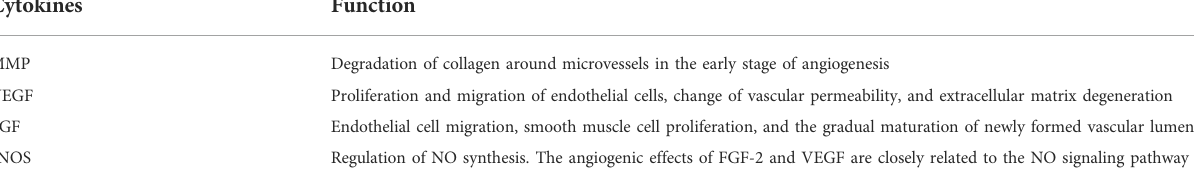
TABLE 1 Function of angiogenesis-related cytokines in promoting angiogenesis. Cytokines Function MMP